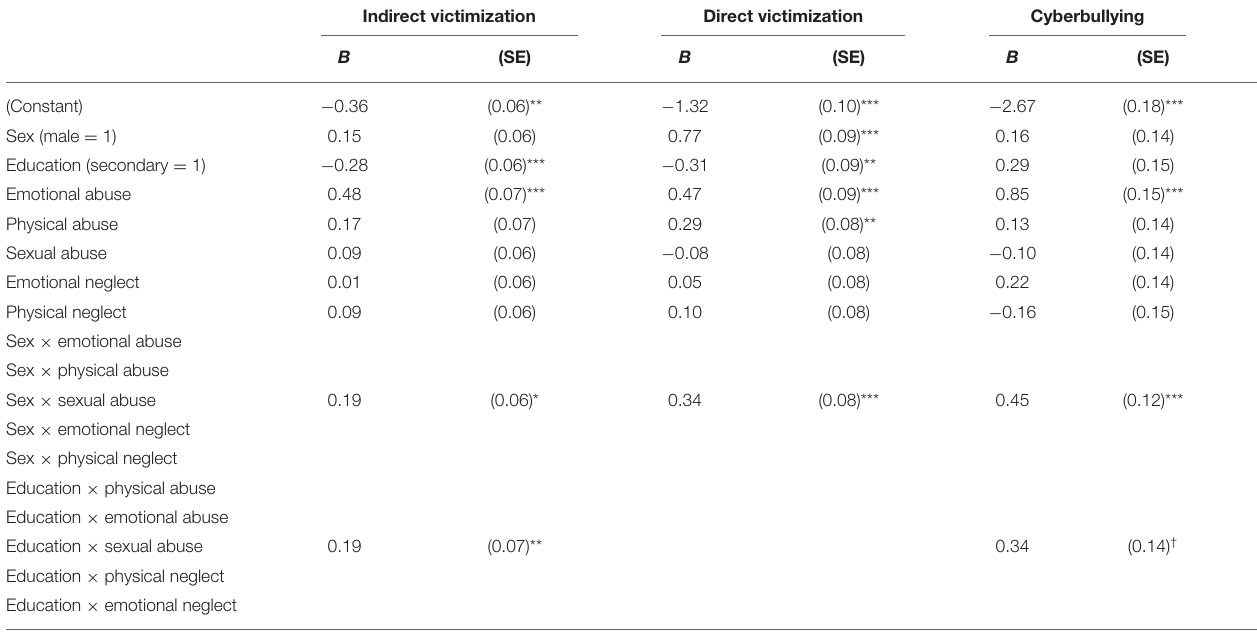
TABLE 3 | Association of specific forms of child abuse and neglect with subtypes of peer victimization ( N = 2.415). Indirect victimization Direct victimization